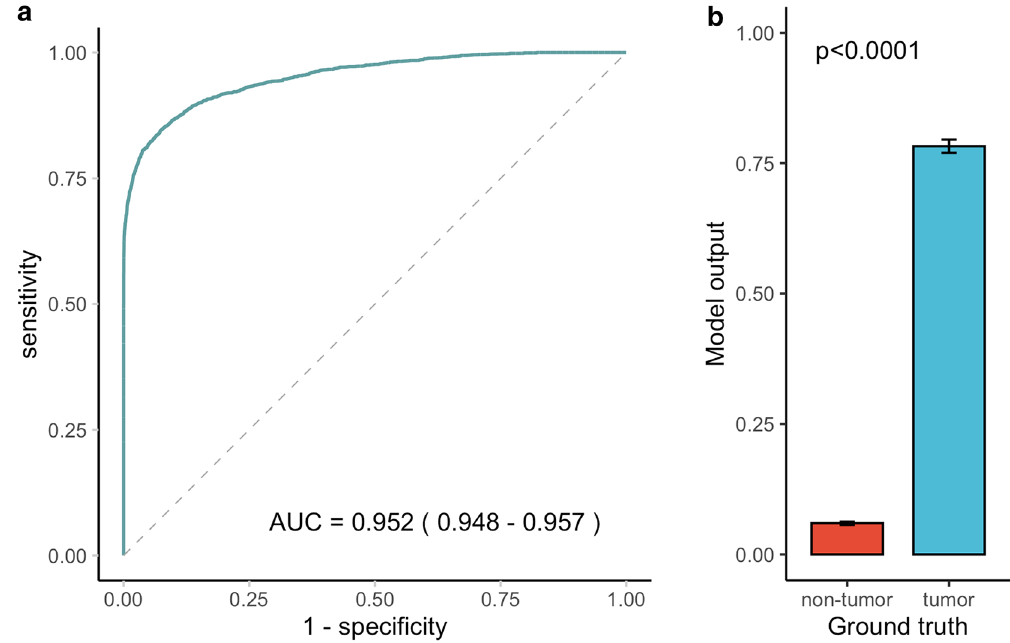
Figure 2. Performance of the tumor tile classification model on the internal test set. The AUROC for tumor tile classification was 0.952 (95% CI 0.948, 0.957) on the internal test set ( a ). Model outputs differed significantly between tiles with a ground truth of tumor versus non-tumor ( p value < 0.0001) ( b ). *The 95% CI for AUC is shown in parentheses in the ROC plot. **Error bars represent 95% CI in the bar chart. The p value was computed using the Wilcoxon rank sum test. AUC, area under the ROC curve; CI, confidence interval; ROC, receiver operating characteristic.